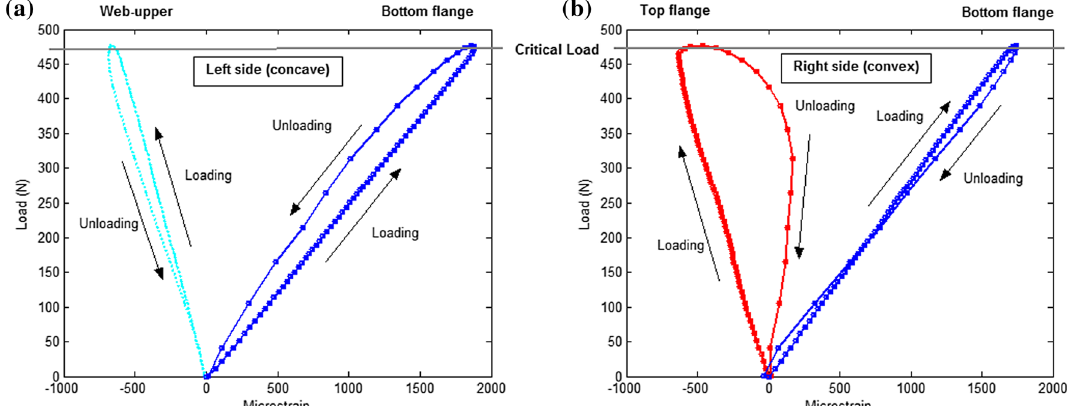
Fig. 14 Variations in the longitudinal strains measured at the a left and b right sides of the ST1 beam at the